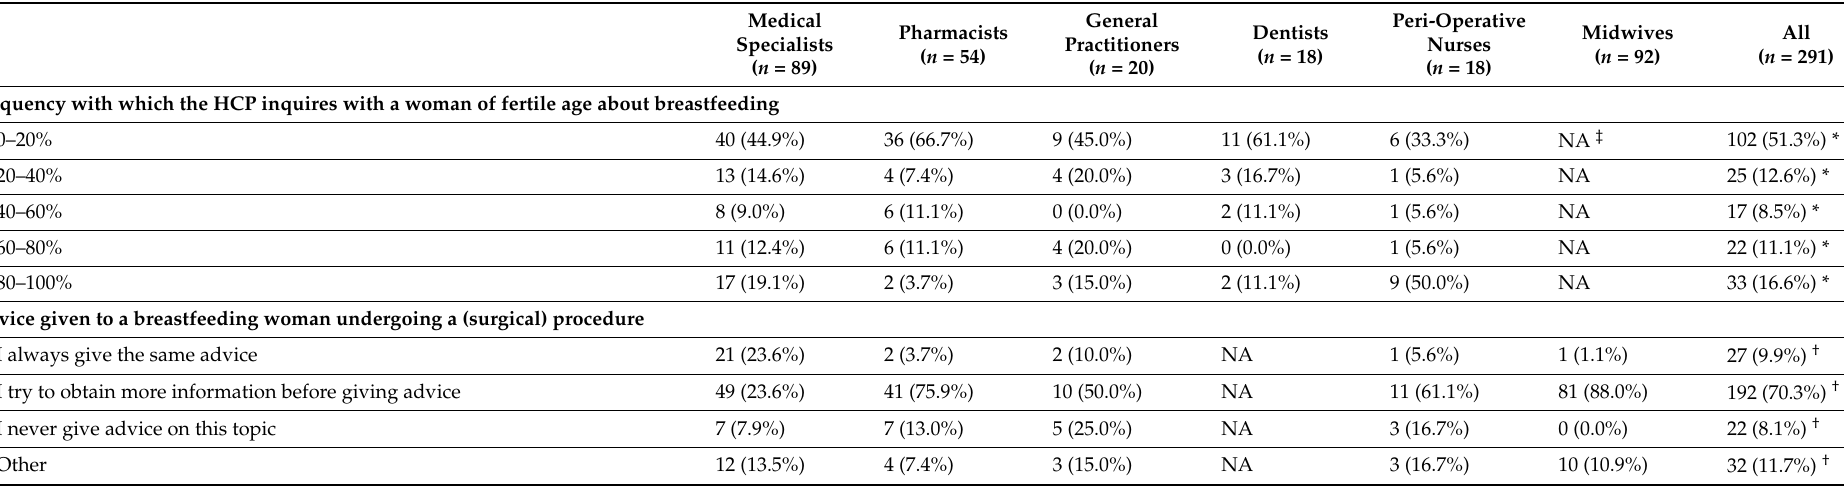
Table 4. Current advice on peri-surgical measures for breastfeeding women. Data shown as number